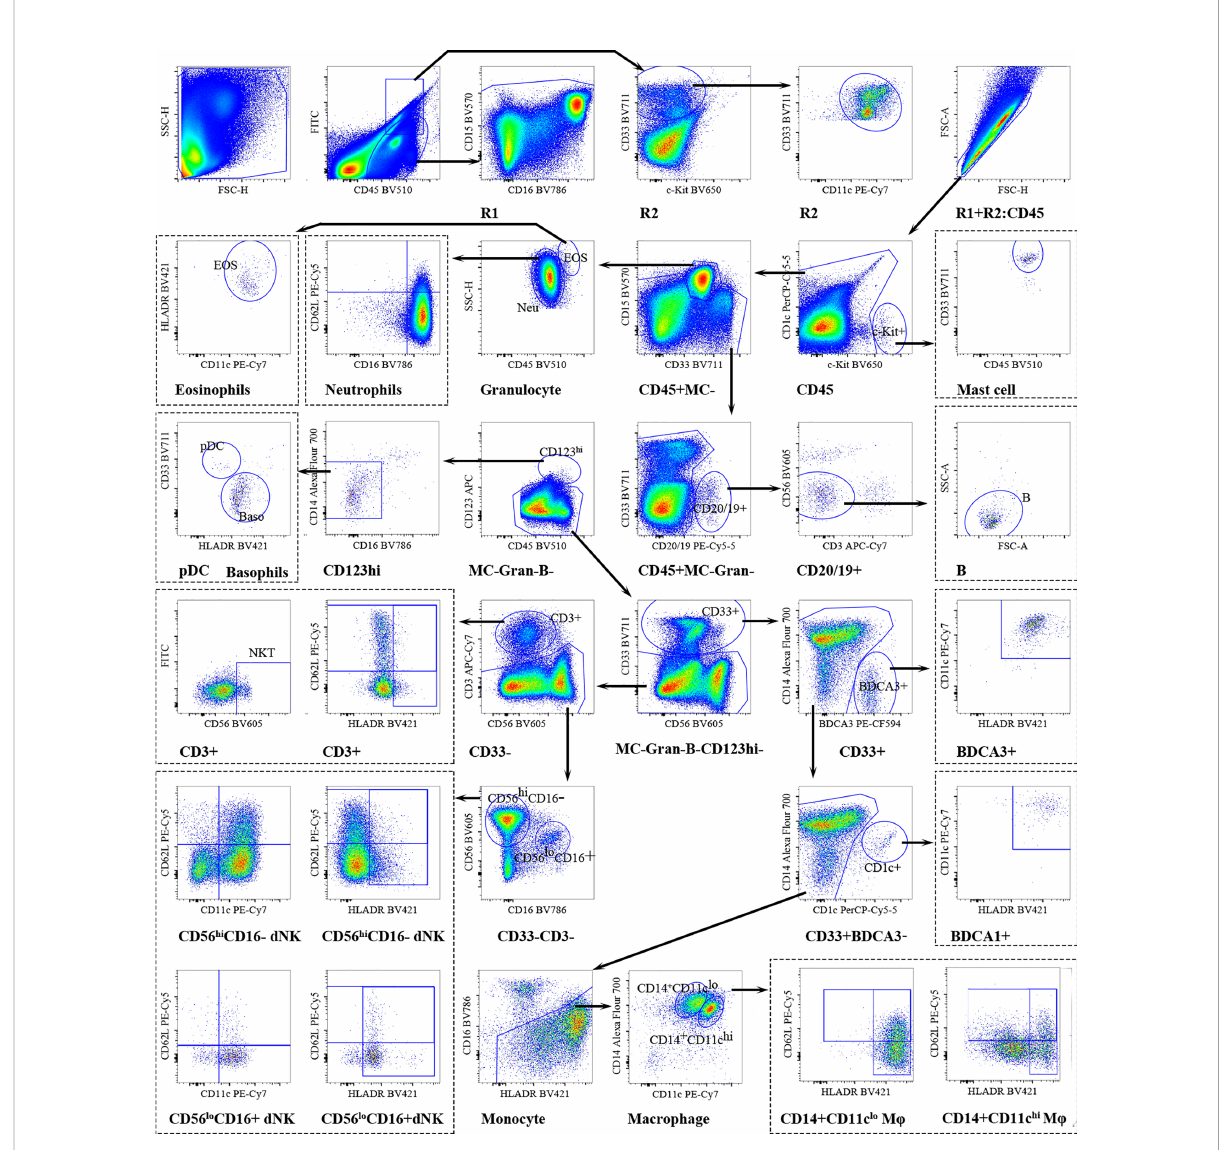
FIGURE 3 Overview of decidual immune cells gating strategy. Representative polychromatic dot plots demonstrating the gating strategy used to identify decidual immune cell content in RPL patients and HDs. All leukocytes were selected using CD45-positivity and then divided into separate cell subpopulations as